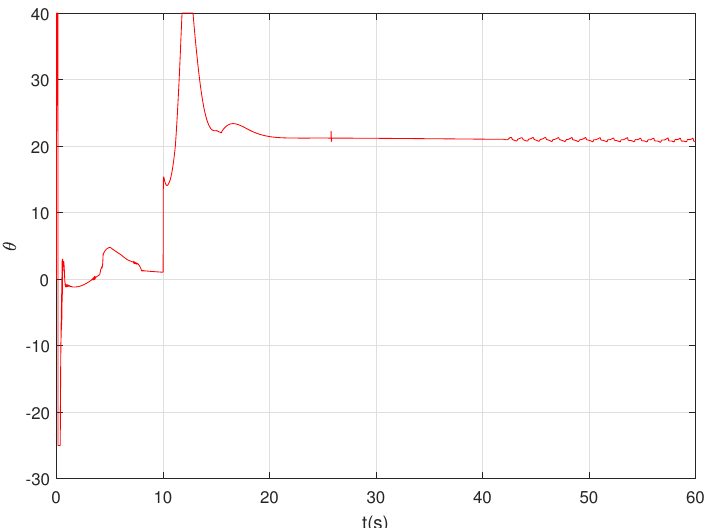
Figure 11. Roll angle of trajectory tracking.